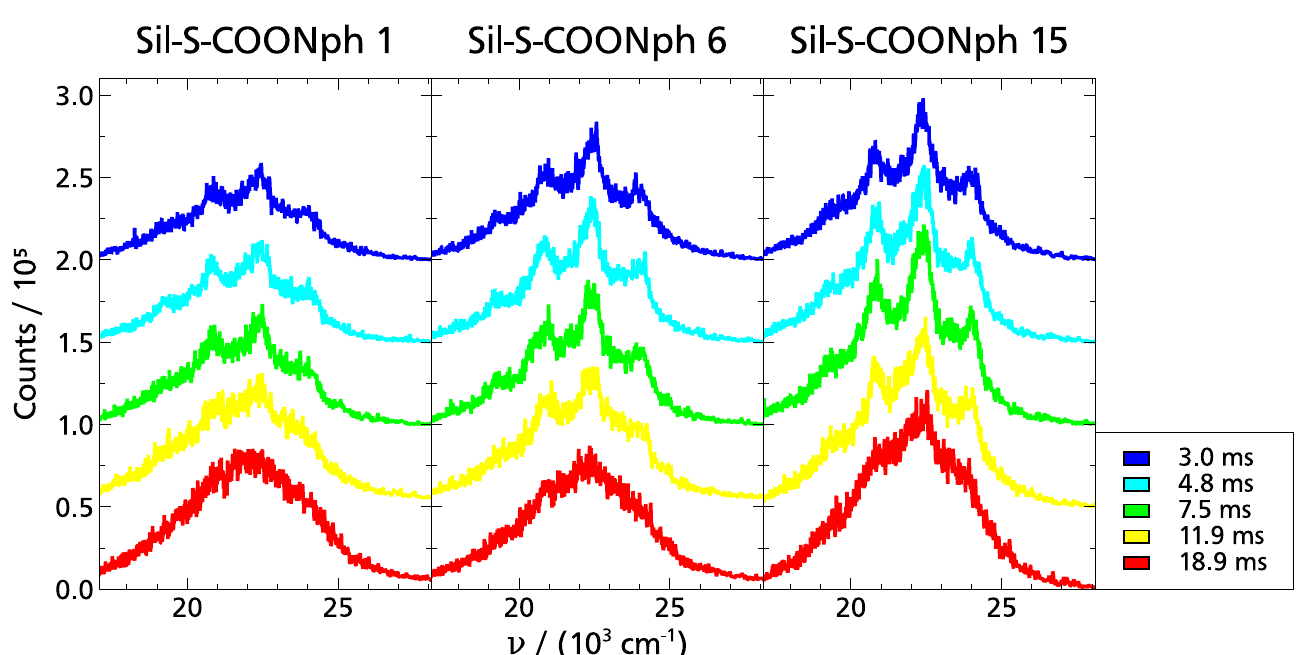
Figure 7. TSD measurement on functionalized spherical silica in 1-propanol at T = 90K. Phosphorescence spectra are shown for different times after excitation of the dye molecules by the UV laser pulse. For better clarity, the spectra are shifted in the y -direction at different delay times t . From left to right, the distance between different NphMet molecules anchored to the spherical silica particles increases. For all functionalizations, it can be observed that the visible structure in the spectra decreases as t